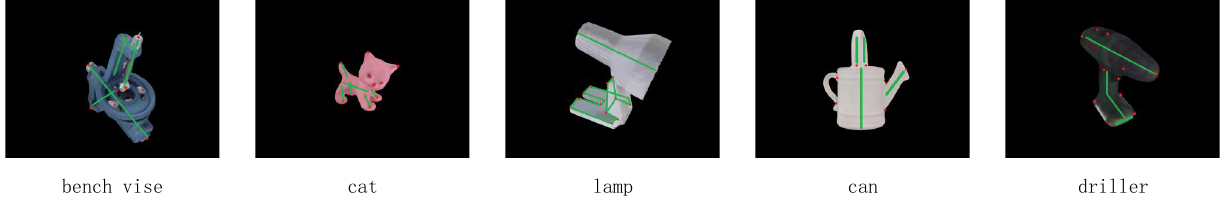
lamp can driller Figure 15. Keypoints and structures definition of bench vise, cat, lamp, can, and driller. The red points represent the selected keypoints, and the green line segments represent the selected structures.